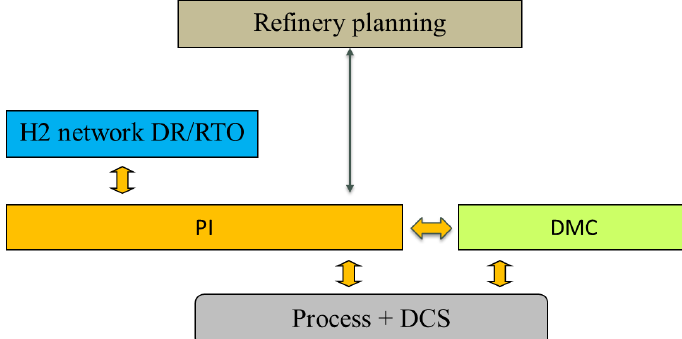
Figure 9. Block diagram of the main elements involved in the hydrogen network management.